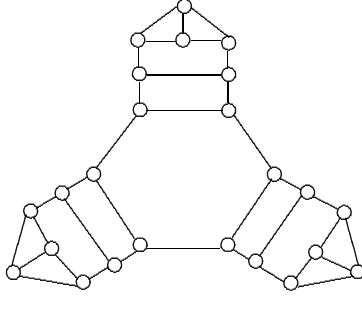
Figure 3: The plane graph G